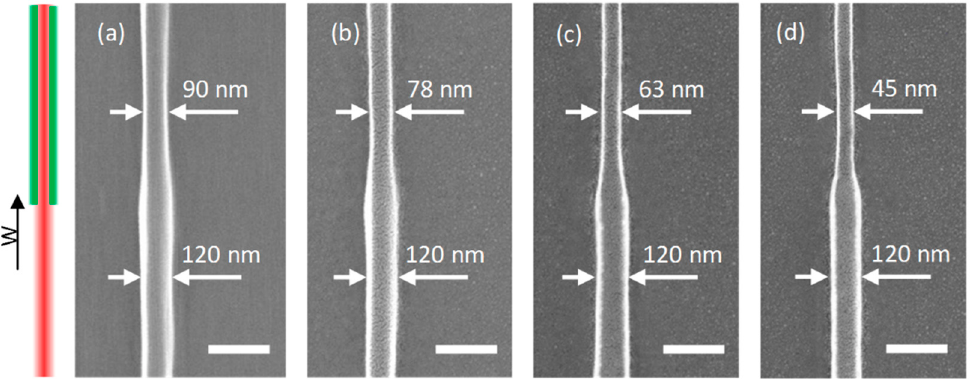
Figure 5. STED direct laser writing nanowires with 11 mW two-photon excitation power and various depletion powers, ( a ) 10 mW, ( b ) 15 mW, ( c ) 20 mW, ( d ) 25 mW depletion laser (green) power. The arrow W indicates the scanning direction, scale bar 200 nm.